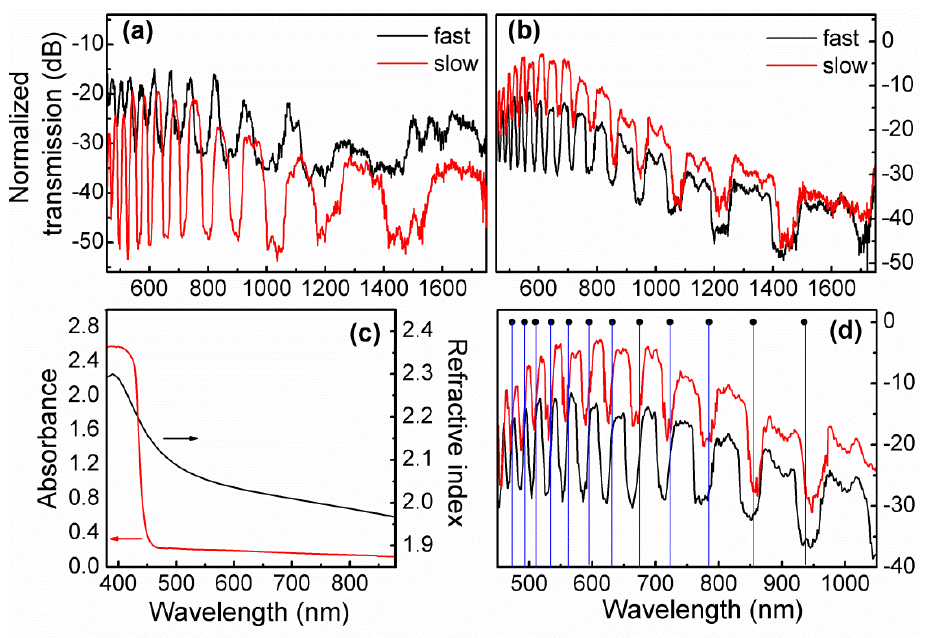
Figure 4. Transmission spectra of 1 cm long x AgI + (1− x )AgPO fabricated via fast-cooling and slow-cooling methods, for x = 0.3 ( a ), and x = 0.55 ( b ), i.e. , normalized to the corresponding spectrum of the pristine PCF fiber; ( c ) Absorption and refractive index as obtained from ellipsometry for glass with x = 0.55; ( d ) Focus on the short wavelength guiding regime between 450 and 1050 nm for glass with x = 0.55, along with ARROW model prediction of the transmission minima [2]. The modal order of the 935 nm notch is m =